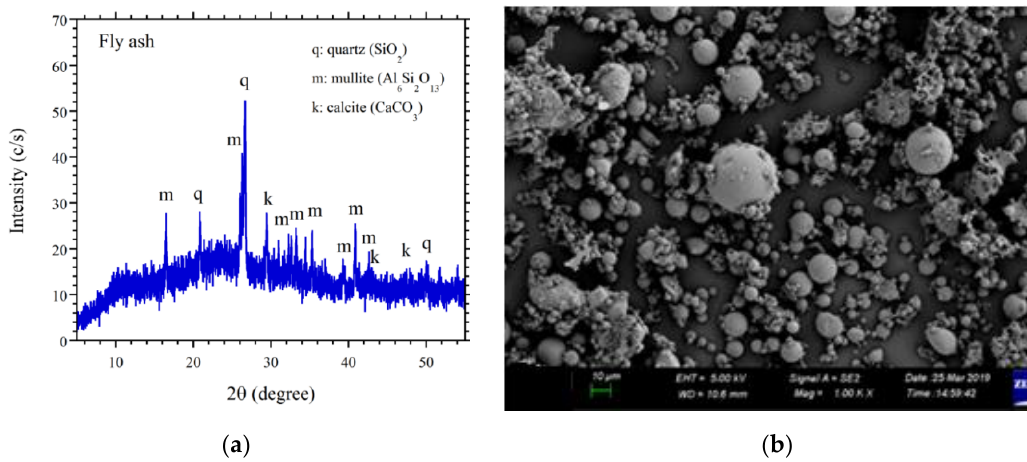
Figure 1. ( a ) X-ray powder diffraction (XRD) analysis and ( b ) scanning electron microscope (SEM) image of the fly ash